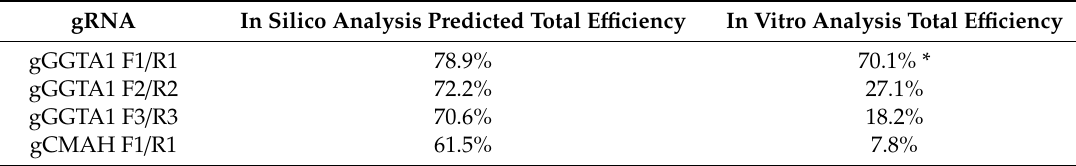
Table 2. Comparison of the results of total efficiency predicted in silico with the results obtained in the in vitro cultured cells.